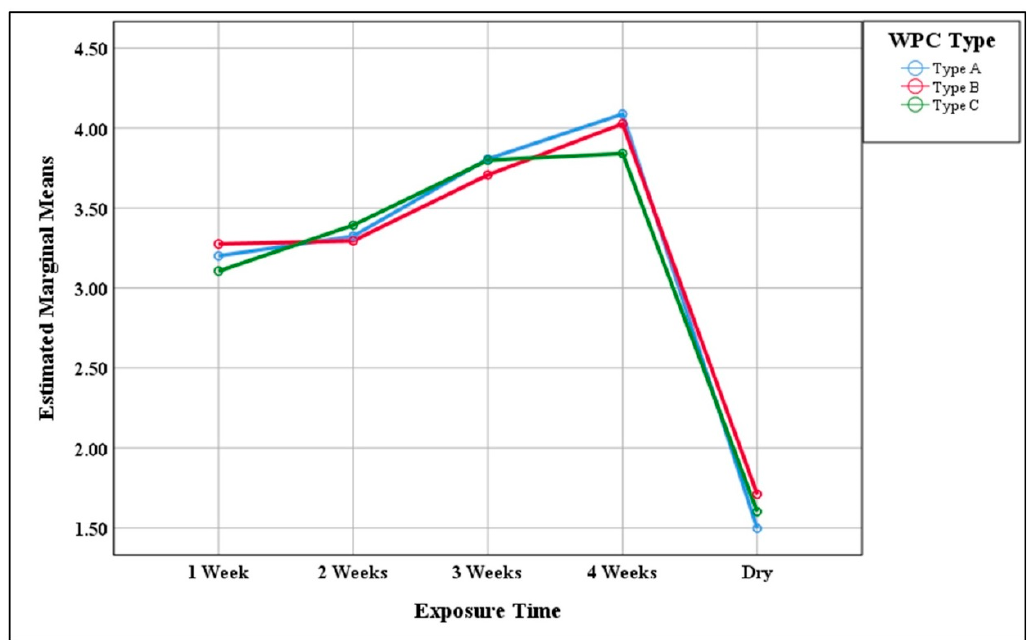
Figure 4. The main effects plot of the mean Surface Roughness (R a ) value for each combination of the groups of WPC Type and Water Exposure Time.